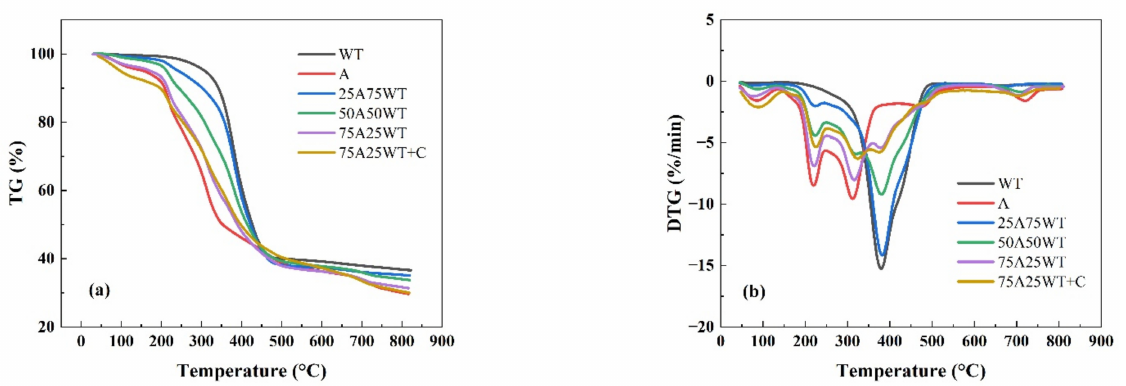
Figure 4. ( a ) TG and ( b ) DTG curves of AP, WTS, and their blends with and without HZSM-5 at 25 ◦